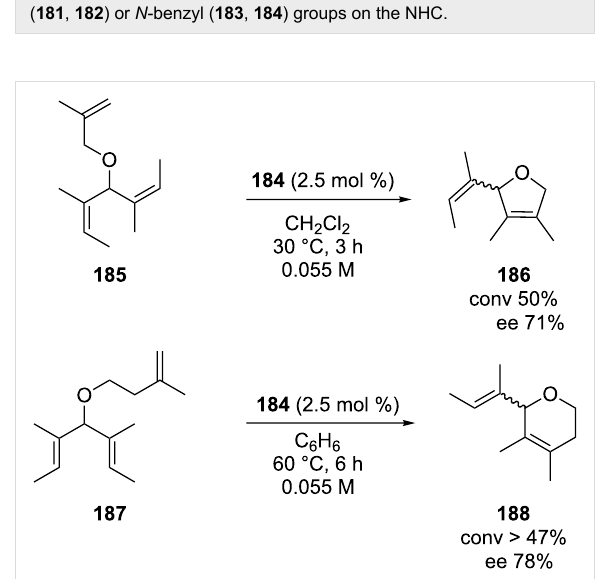
Scheme 17: ARCM of 185 and 187 promoted by 184 to form the encumbered alkenes 186 and 188 .